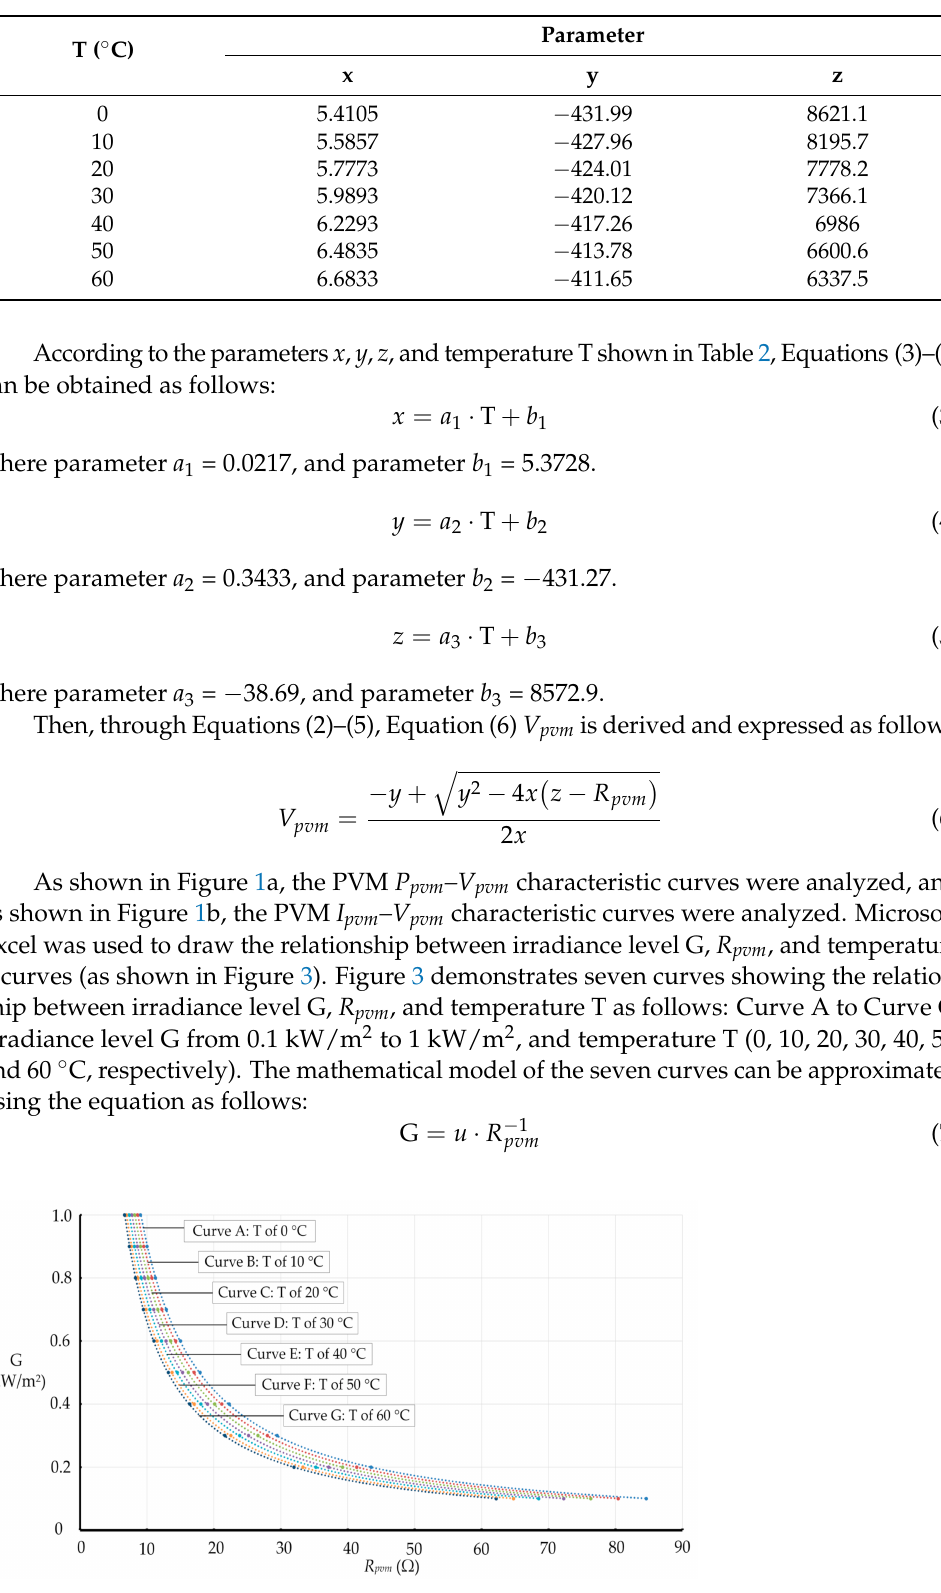
Table 2. Relationship between the parameters x , y , z , and temperature T.